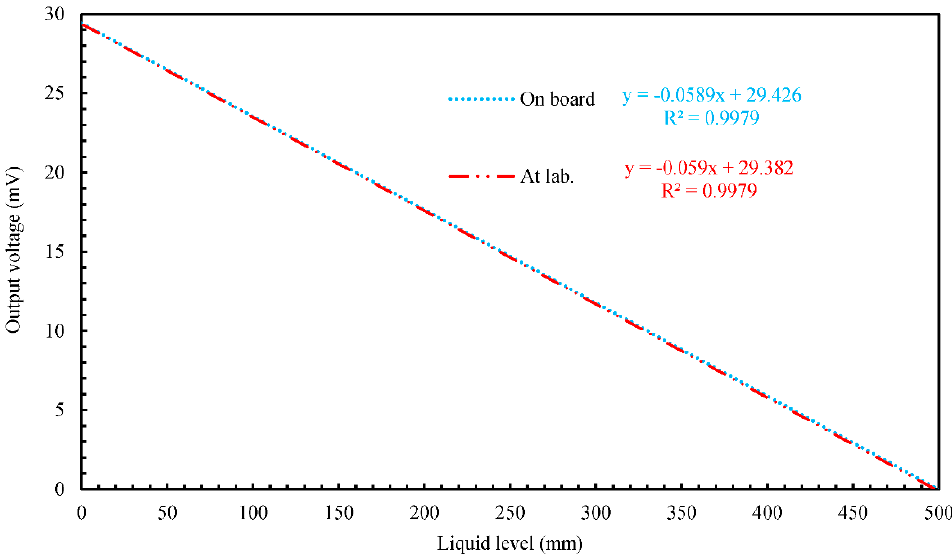
Figure 8. Comparison of onboard and laboratory results for the static level-detecting characteristics of the 500 mm long MgB 2 level sensor A1 at a heater input of 9 W. the 500 mm long MgB 2 level sensor A1 at a heater input of 9